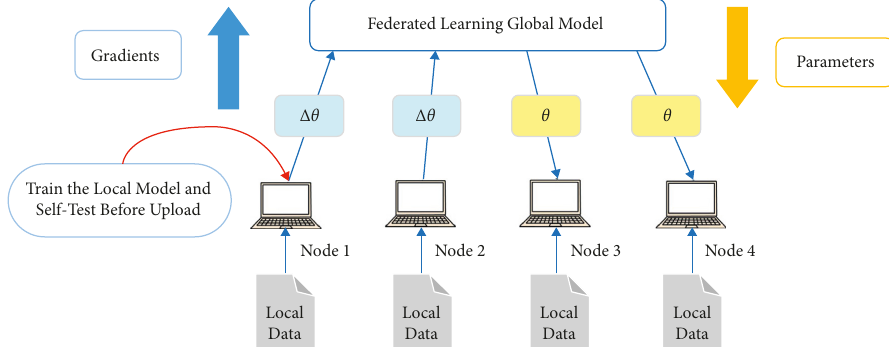
Figure 4: Schematic diagram of the federated learning mechanism.